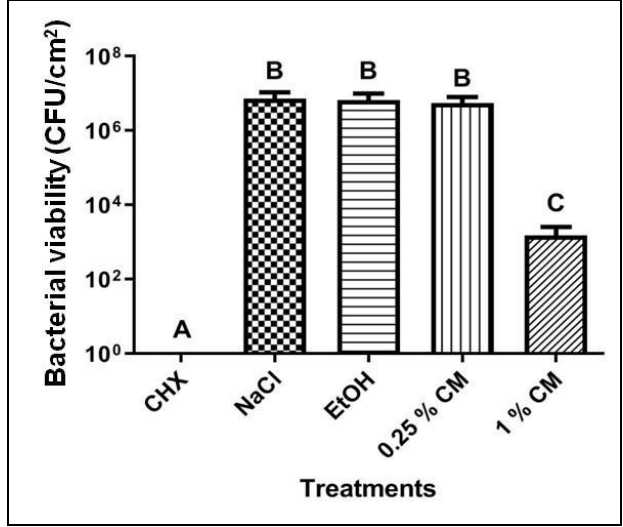
Figure 4. Bacterial viability of S. mutans biofilms treated with chitosan microparticles. CHX: 0.12% chlorhexidine (positive control); NaCl: saline solution (negative control); EtOH: ethanol/phosphate buffer solution (vehicle control); 0.25% CM: 0.25% chitosan microparticles; 1% CM: 1% chitosan microparticles. Data are expressed as mean ± standard deviation (n = 4). Columns not sharing the same letter (A, B, C) are significantly different from each other. ANOVA, Tukey post-hoc test, p < 0.05.